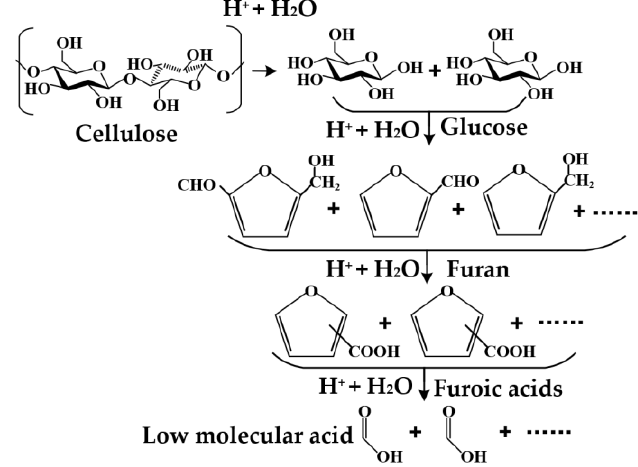
Figure 8. Pathway of cellulose to generate small molecule carboxylic acid.